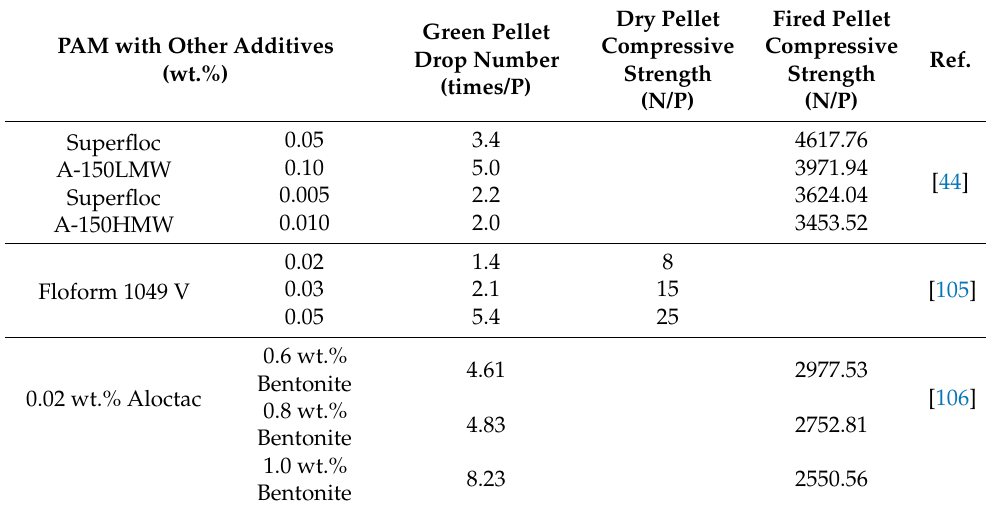
Table 6. The effect PAM with other additives on the performance of